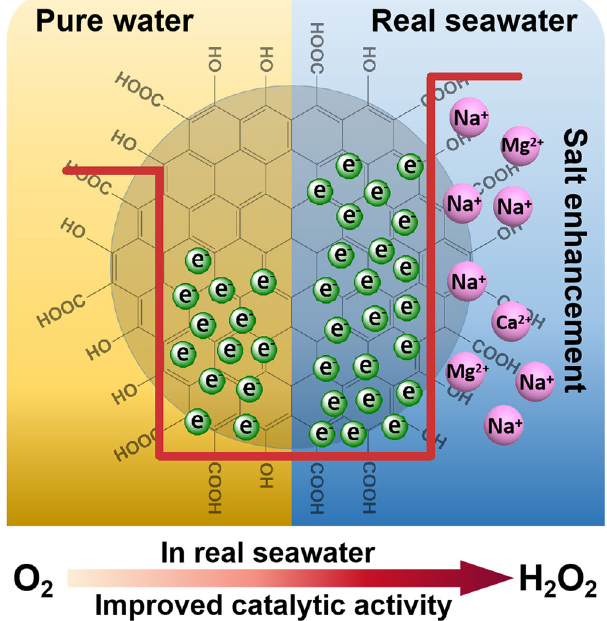
Fig. 6 Schematic mechanism. Schematic mechanism of H 2 O 2 production over PM-CDs-30 through photocatalytic reaction in